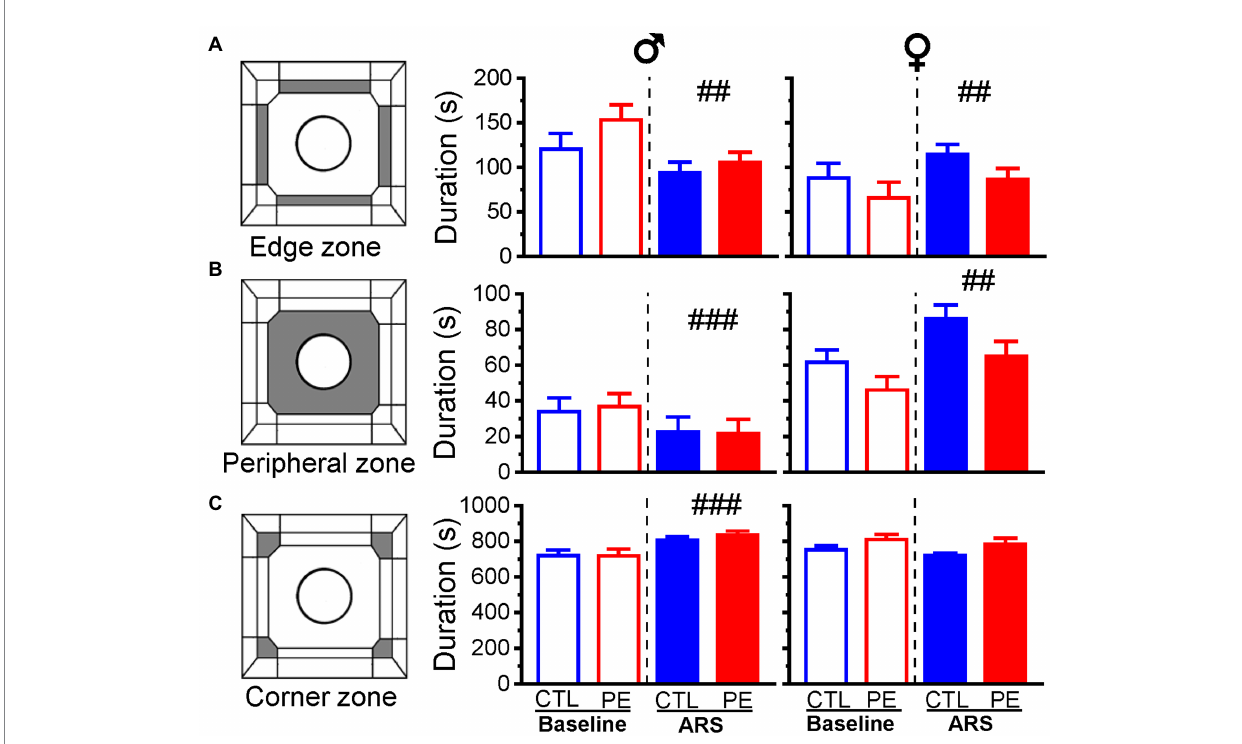
FIGURE 5 Effects of prenatal ethanol exposure (PE) and acute restraint stress (ARS) on duration spent in different zones in the OF: edge zone (A) , peripheral zone (B) , and corner zone (C) in the baseline and after ARS in both male and female rats. Prenatal ethanol exposure did not change the duration in any of the zones. Acute restraint stress exerted sex dimorphic effects on duration in each zone. Data are represented as Mean ± SEM. CTL, ## p < 0.01, ### p < 0.001, baseline condition vs. ARS.